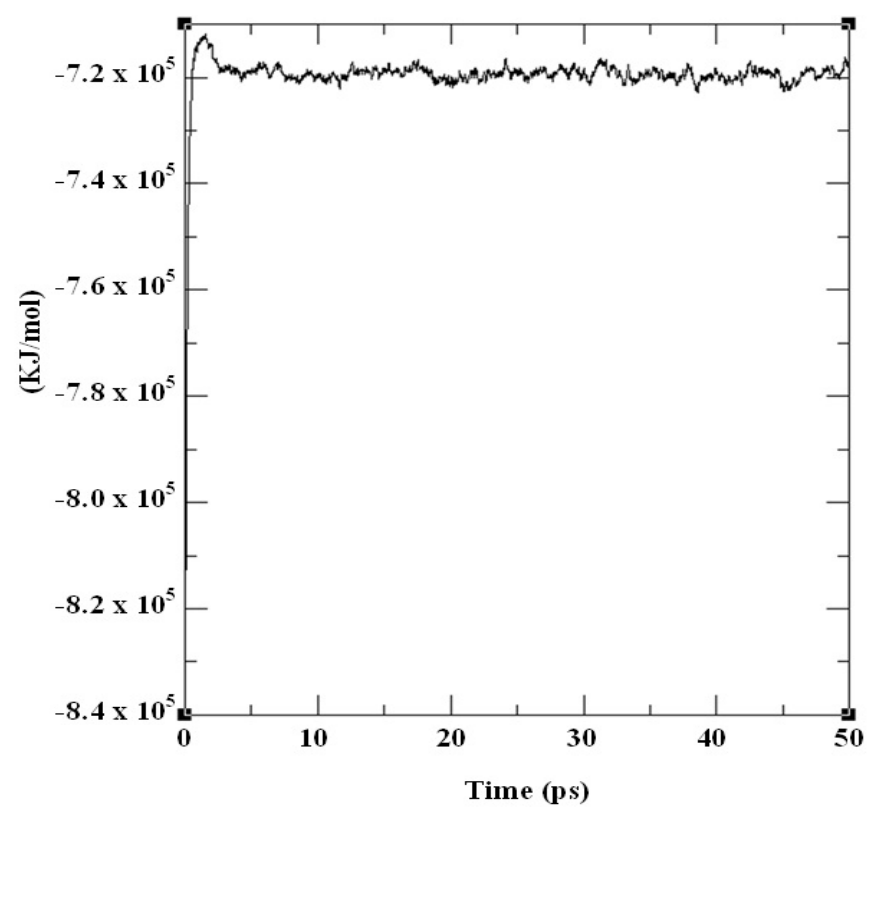
Figure 4. Total energy for the molecular dynamics simulation of